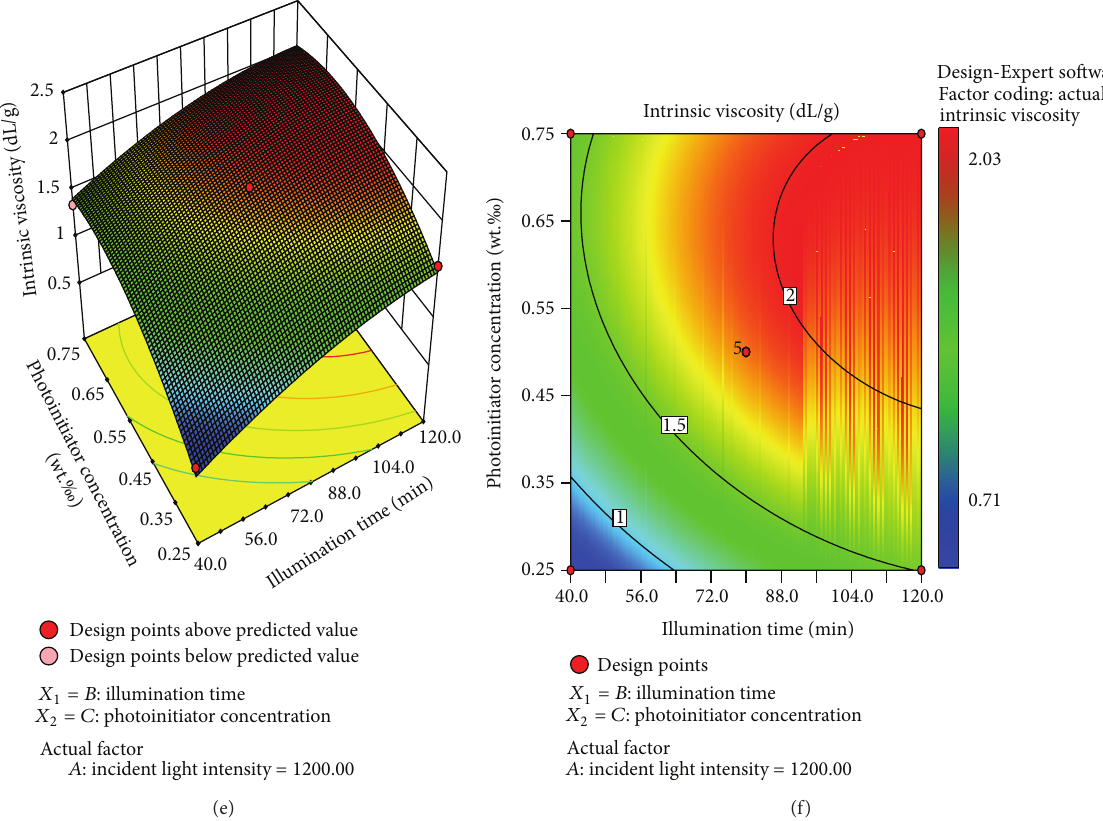
Figure 1: Mutual effect of photoinitiator concentration, incident light intensity, and illumination time on intrinsic viscosity [𝜂] .